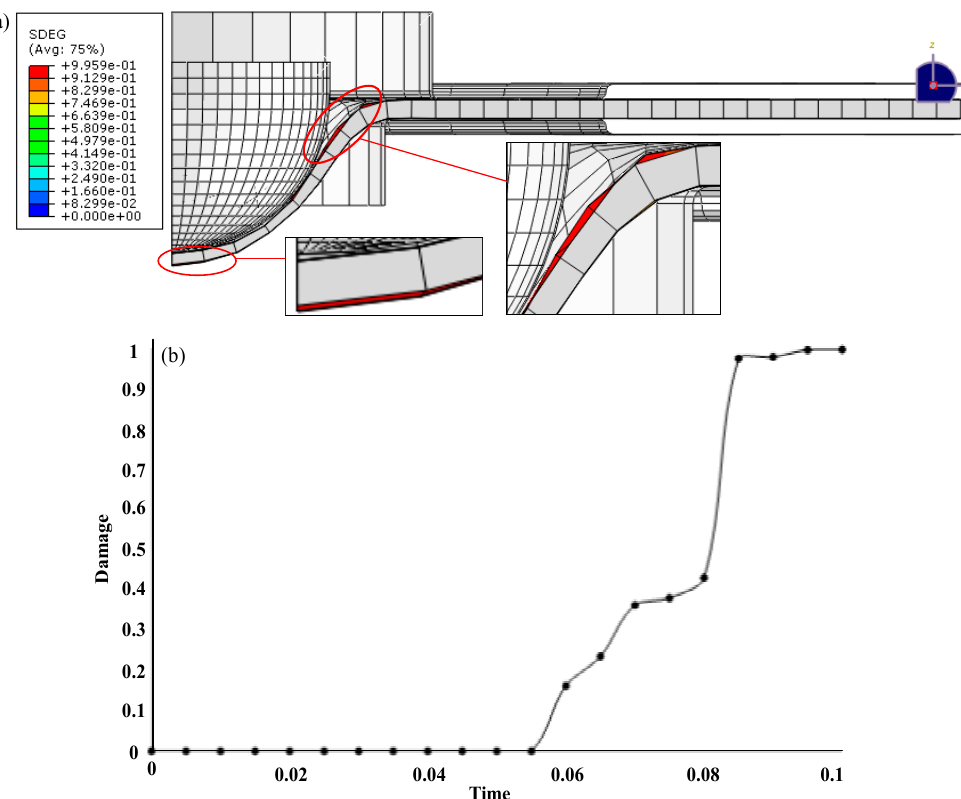
Figure 16. Failure of cohesion element under blank holder force 50 kN: ( a ) Damage of zinc coating layers, ( b ) Damage of zinc coating layers with drawing time.